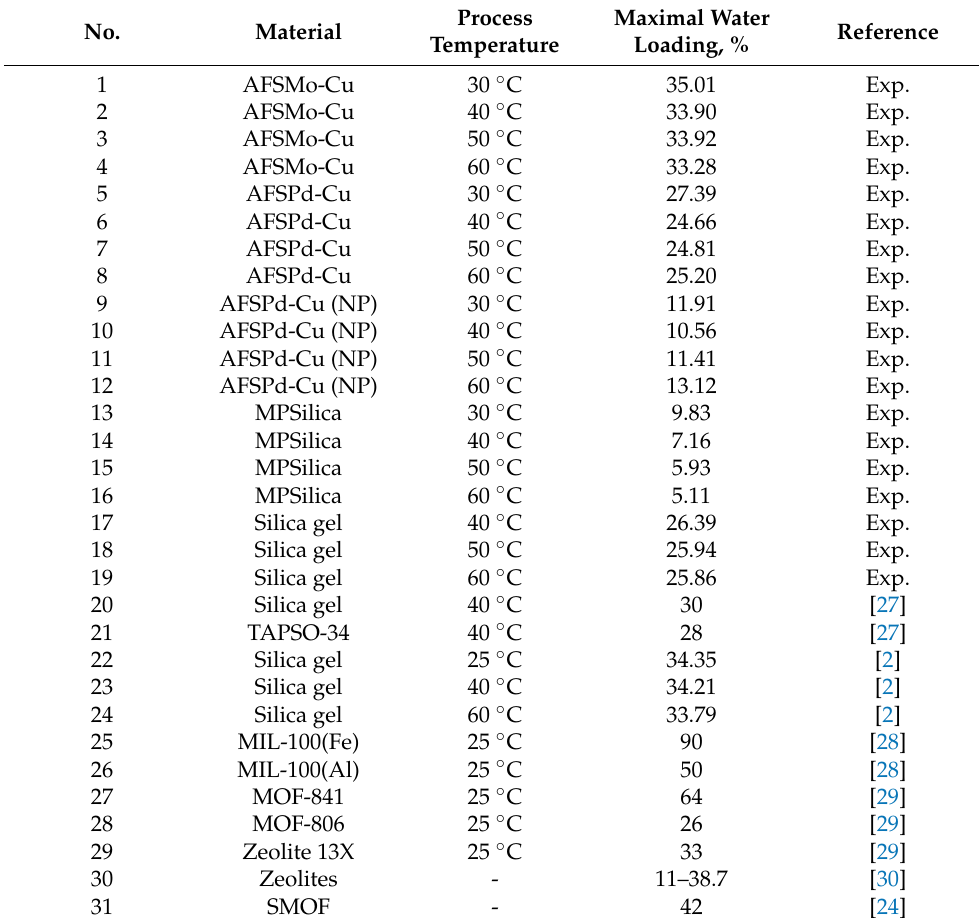
Table 3. Comparison of water adsorption capacities determined for sorbents analysed in this study with literature data regarding porous materials characterised by high water adsorption